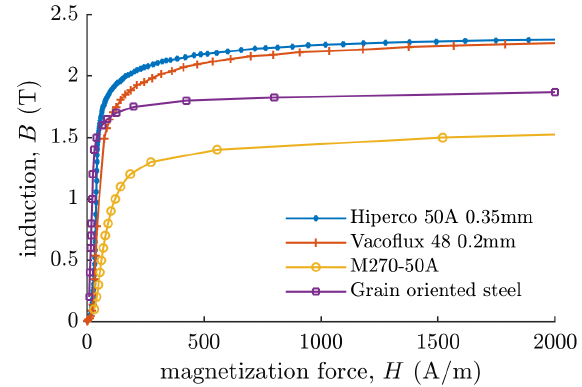
FIG. 3. Magnetization curves of standard FeSi, grain oriented and FeCo